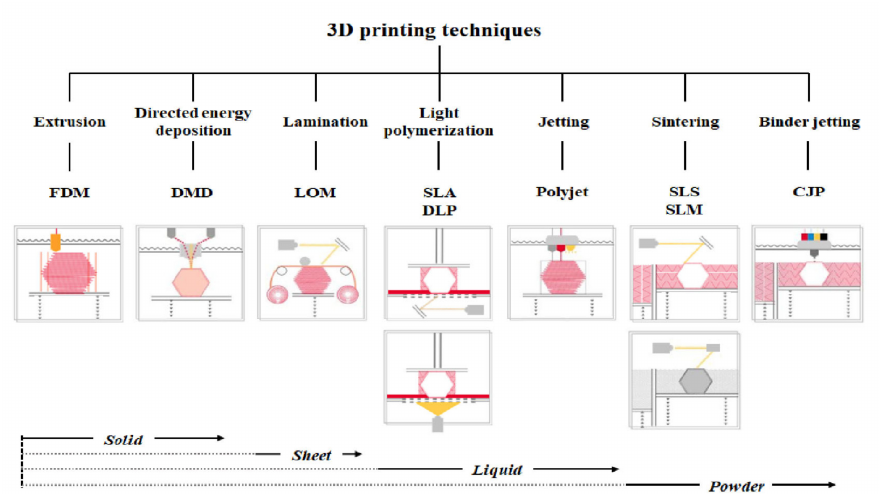
Figure 1. Three-dimensional printers classified according to type and material.